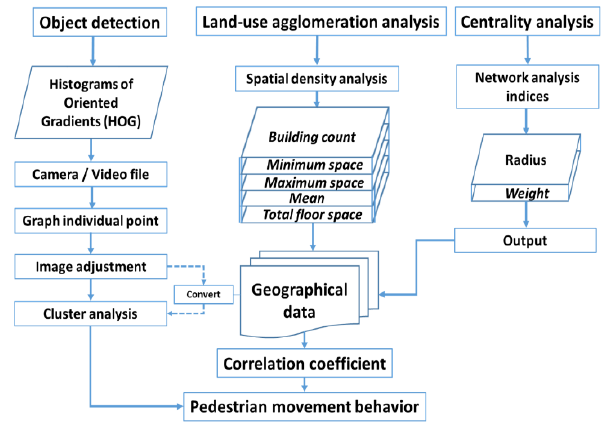
Figure 1. Research framework